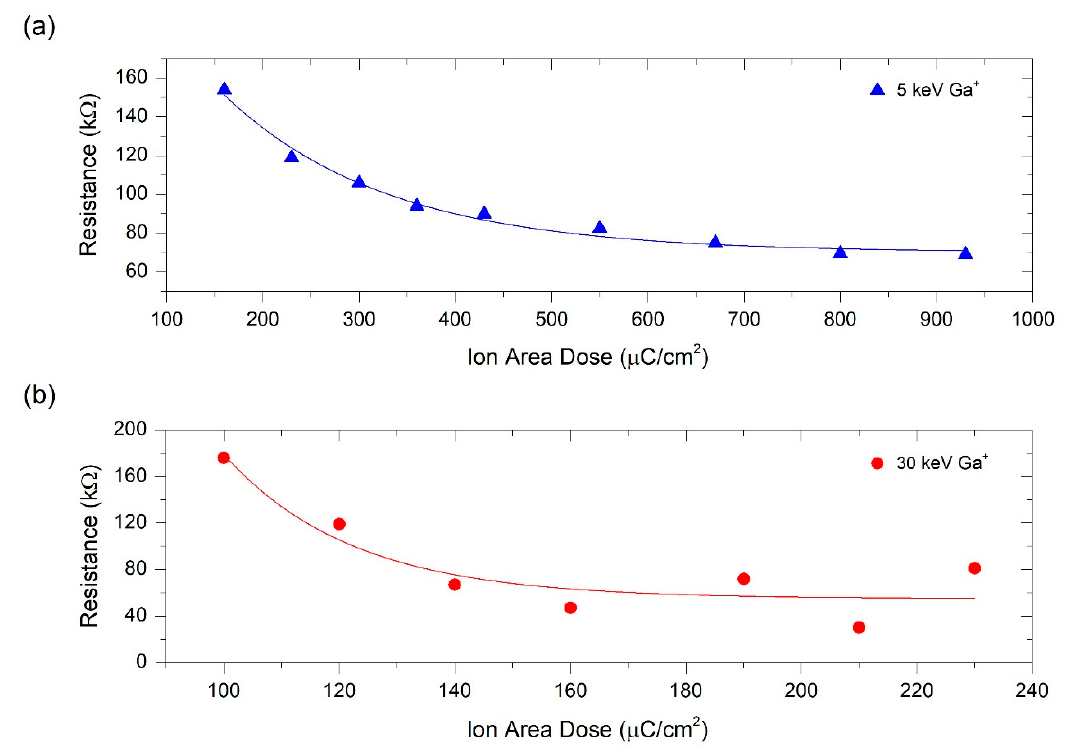
Figure 3. Electrical resistance of Pt-C deposits as a function of the ion area dose used in the Cryo-FIBID process. ( a ) Resistance values corresponding to deposits grown at 5 keV Ga + ; ( b ) Resistance values corresponding to deposits grown at 30 keV Ga + .